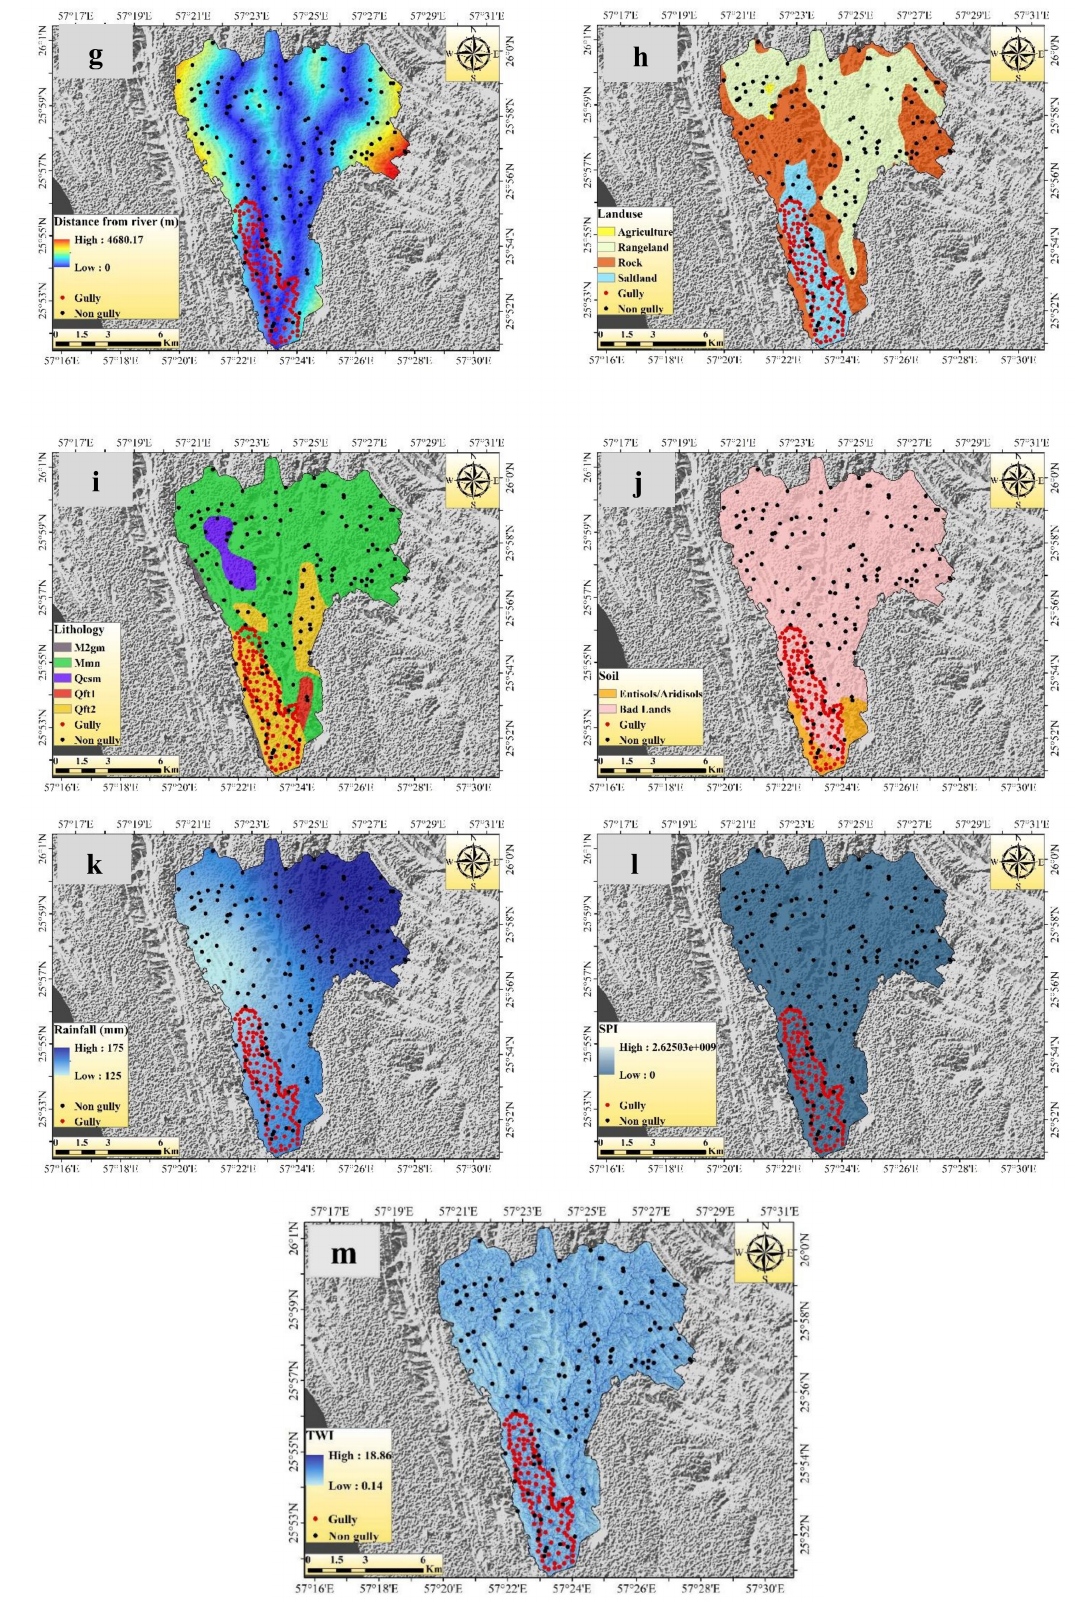
Figure 4. Gully erosion conditioning factors: ( a ) altitude, ( b ) slope, ( c ) aspect, ( d ) plan curvature, ( e ) profile curvature, ( f ) drainage density, ( g ) distance from a river, ( h ) land use, ( i ) soil, ( j ) lithology, ( k ) rainfall, ( l ) stream power index (SPI), and ( m ) topographic wetness index